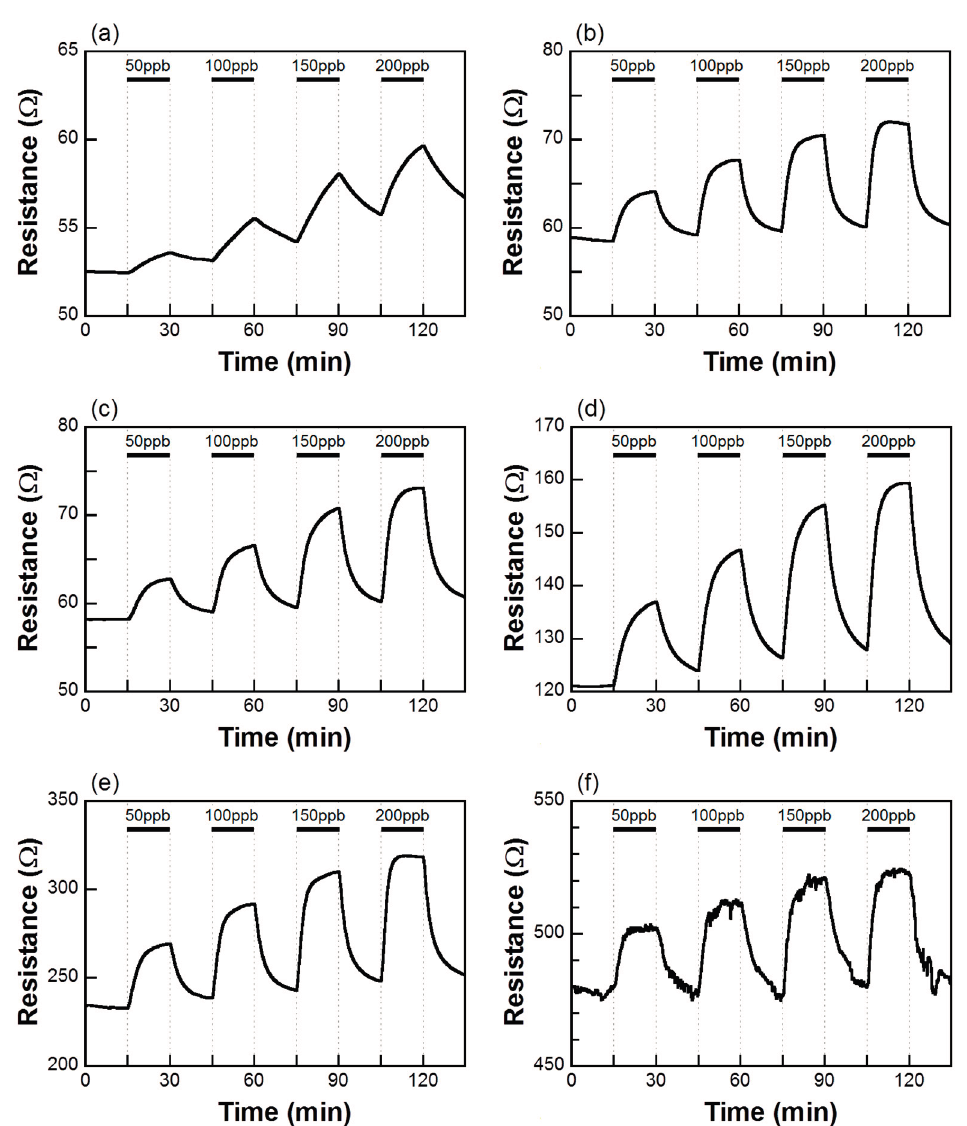
Figure 2. Responses of the sensor element using ( a ) Co 3 O 4 ; ( b ) 0.1%Pd/Co 3 O 4 ; ( c ) 1%Pd/Co 3 O 4 ; ( d ) 5%Pd/Co 3 O 4 ; ( e ) 10%Pd/Co 3 O 4 ; and ( f ) 30%Pd/Co 3 O 4 powder during exposure to NO (50, 100, 150, and 200 ppb) in air at 200